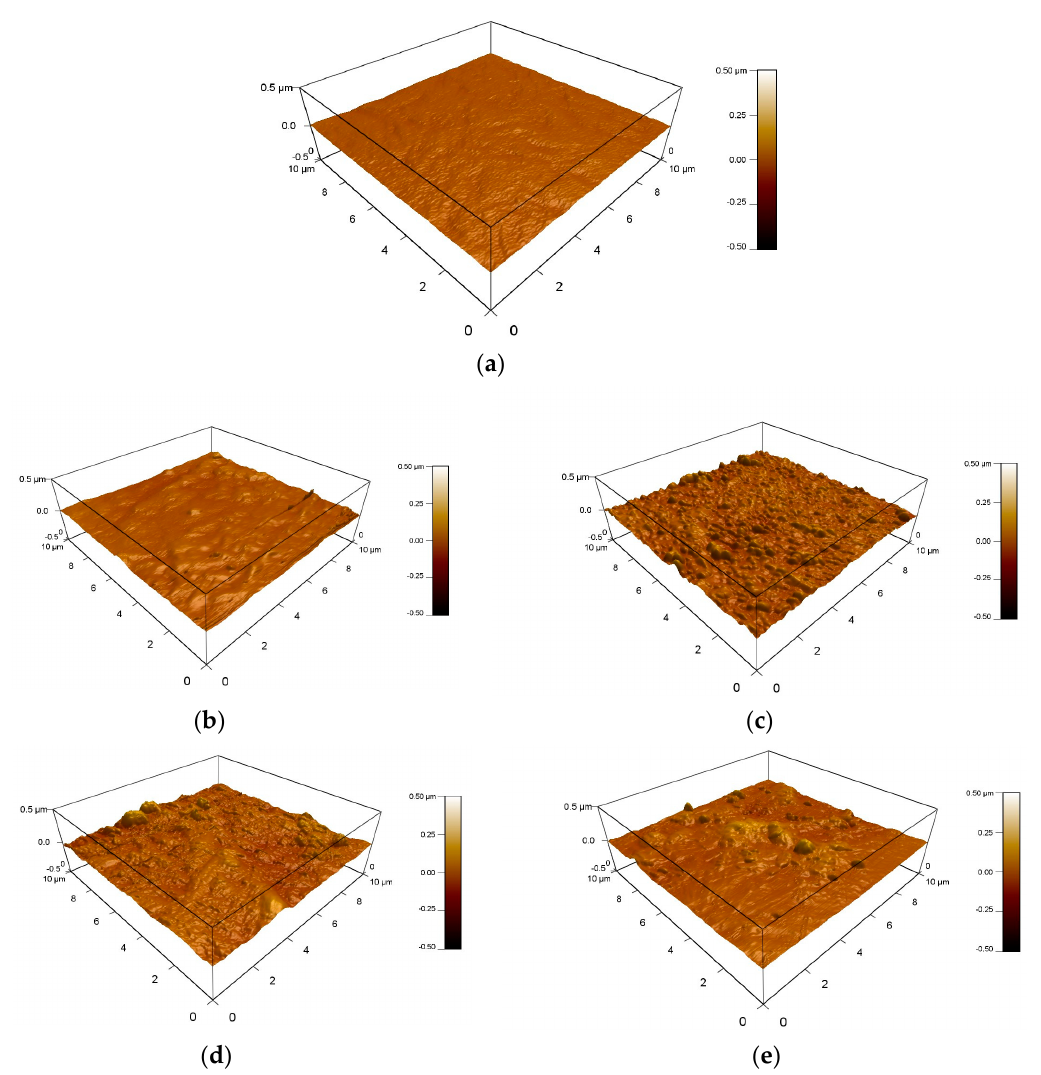
Figure 15. Atomic force microscopy (AFM) height images of the PU films: ( a ) untreated ( R a = 6.3 nm), and plasma treated (180 s) using: ( b ) air ( R a = 27.5 nm), ( c ) O 2 ( R a = 20.0 nm), ( d ) N 2 ( R a = 24.7 nm), and ( e ) Ar ( R a = 23.0 nm).